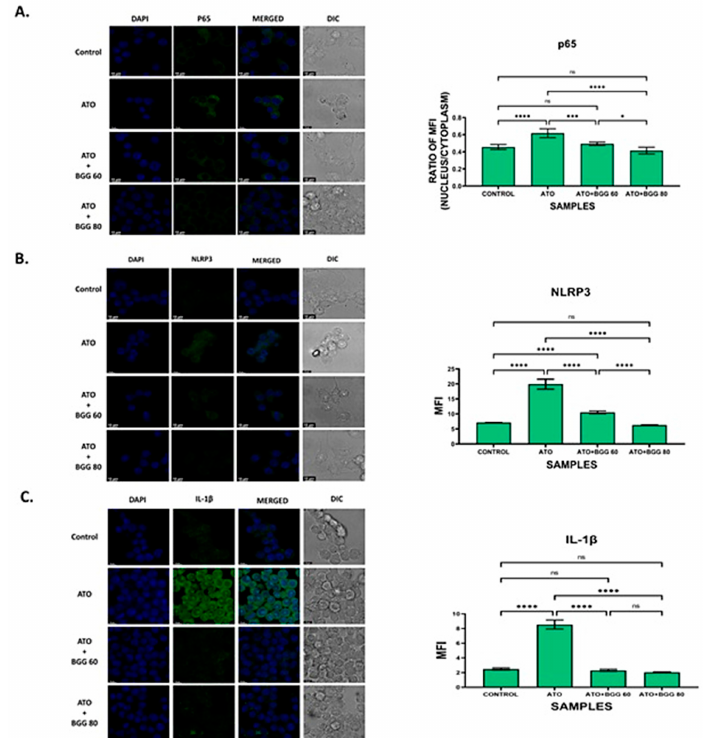
Figure 5. Immunofluorescence staining images demonstrate that BGG reversed the ATO-induced inflammation in the RAW 264.7 cells, measured by confocal microscopy. ( A ) Representation of the translocation of p-65 into the nucleus in RAW 264.7. The histogram represents the ratio of mean fluorescent between nucleus and cytoplasm. ( B ) Immunofluorescence staining shows that BGG protects the ATO-induced inflammasome formation in RAW 264.7 analyzed by NLRP3 ( B ) and IL-1 beta ( C ). Results are mentioned as mean ± SD, (* p ≤ 0.05, *** p < 0.001, and **** p < 0.0001,ns = non-significant) ( n = 3 fields). Scale bars: 10 μ M.